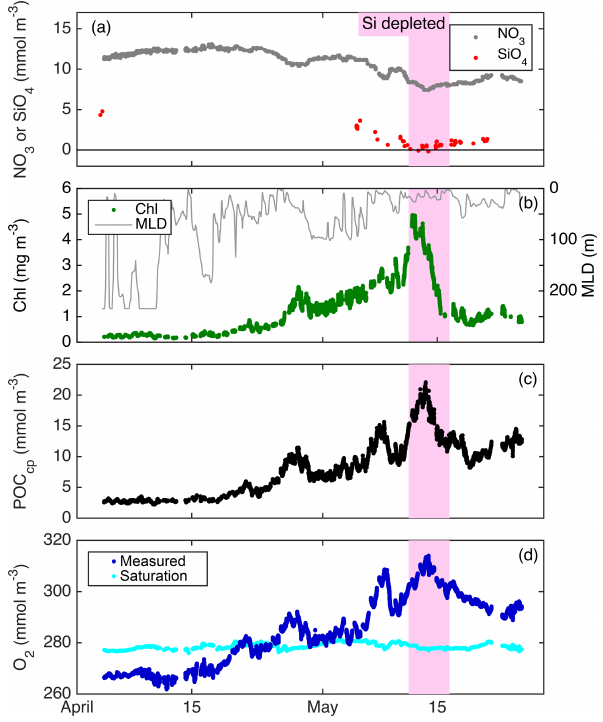
Figure 7. Float patch mixed-layer time series of NO 3 (a) , SiO 4 (a) , MLD (b) , Chl a (b) , POC cp (c) , O 2 (d) , and the concentration of O 2 saturation (d) .